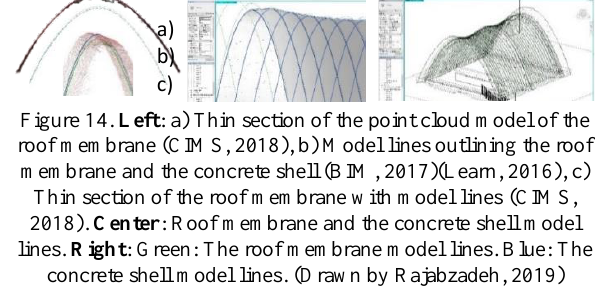
Figure 11. Left: Two separate interior and exterior Point cloud data of the pavilion in CloudCompare software. Right: Shows interior point cloud data in Agisoft Photosca Software. .